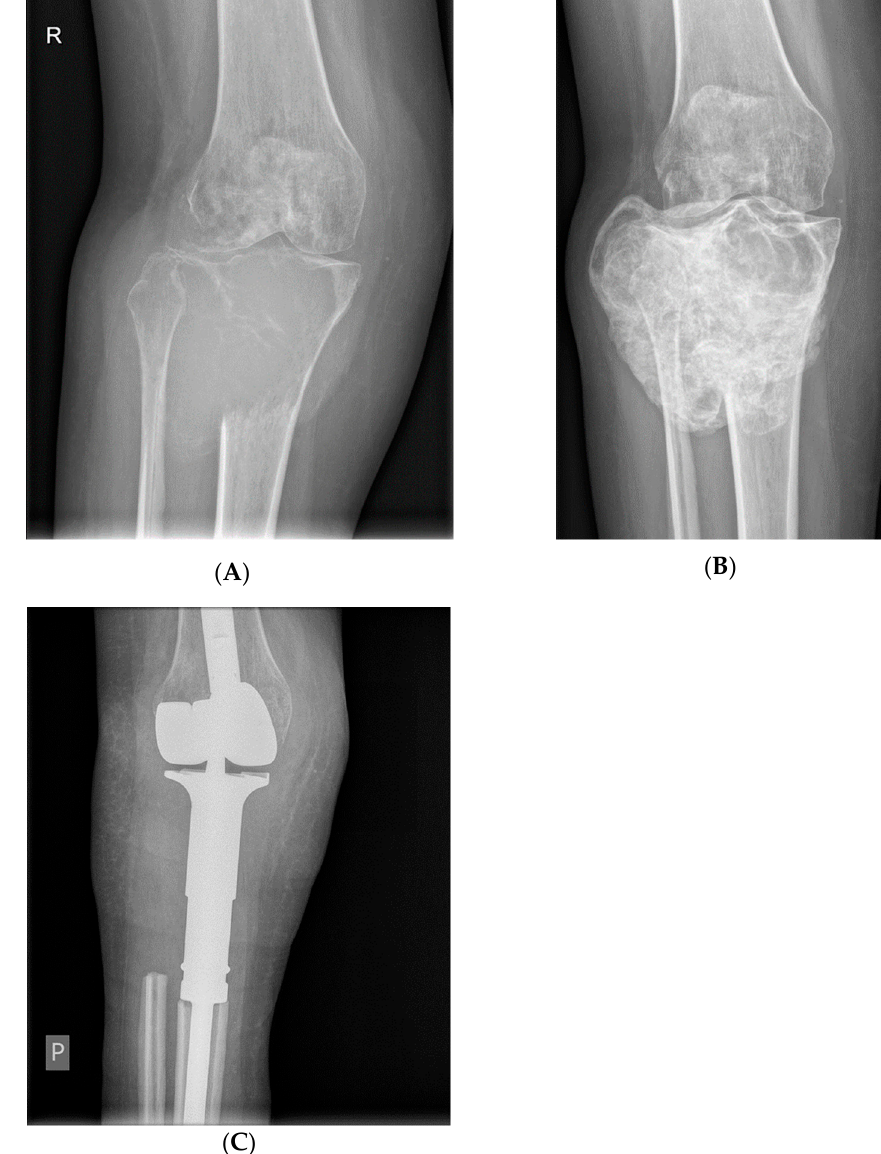
Figure 4. Significant calcification of the locally advanced GCTB of proximal tibia after 8 doses of denosumab (X ‐ rays). Prolonged denosumab treatment can aid resection of the initially inoperable cases. ( A ): Lesion before denosumab therapy, ( B ): after 8 doses of denosumab, ( C ): after the surgery with radical resection and implantation of oncological prosthesis.